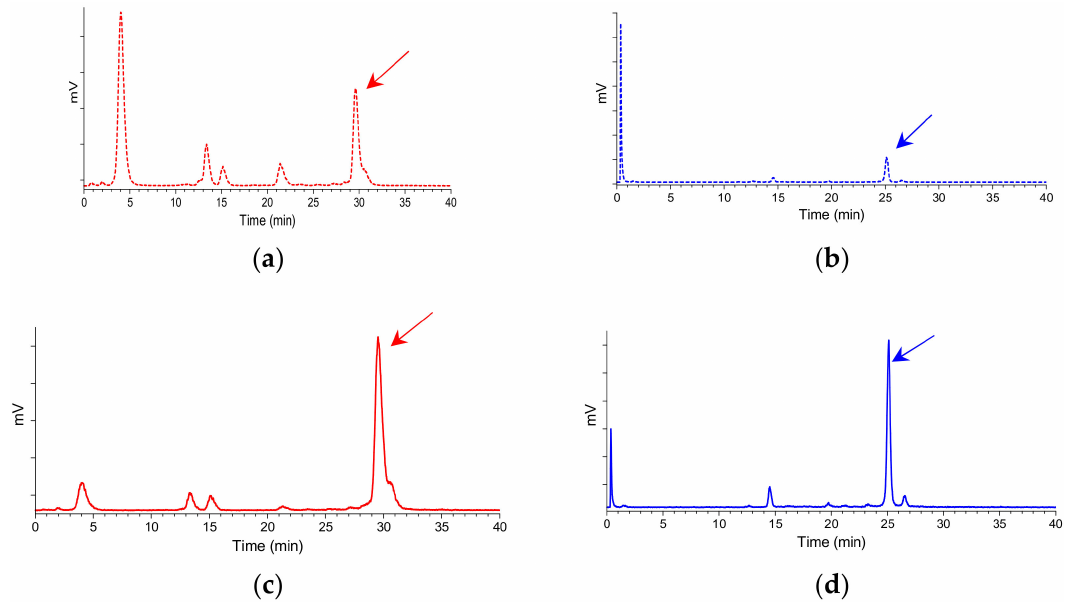
Figure 4. Representative radiochromatograms of HPLC analysis of mouse blood samples collected 5 min pi of ( a ) 99m Tc-N 4 -GRP(14–27) (25.2% intact radiotracer; red dashed line) or ( b ) 99m Tc-N 4 -GRP(18–27) (31.8% intact radiotracer; blue dashed line) without PA coinjection; the respective radiochromatograms